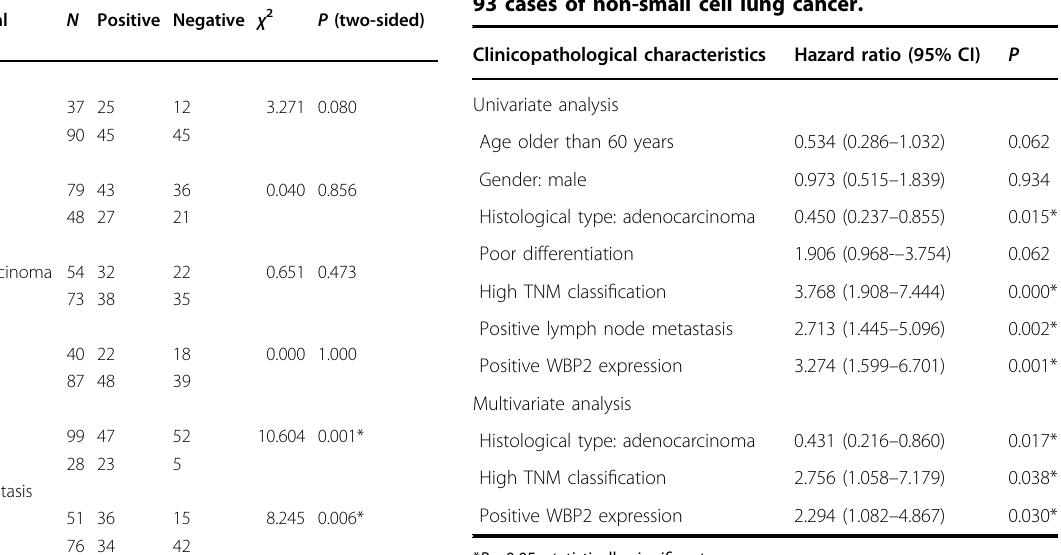
Table 1 Association of WW domain binding protein-2 (WBP2) expression with clinical and pathological characteristics in non-small cell lung cancer (NSCLC).